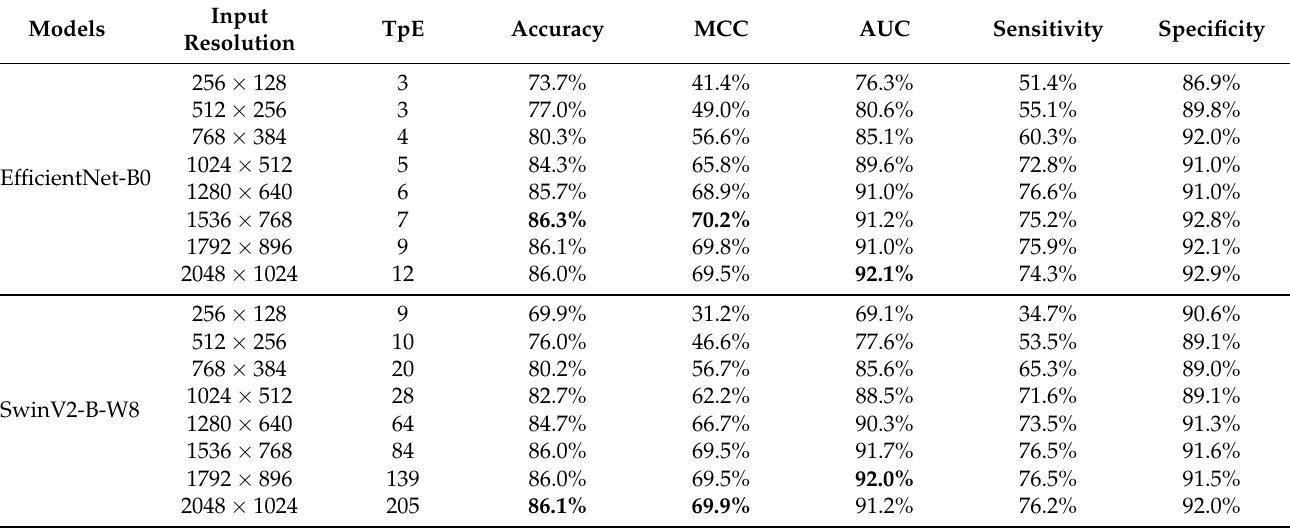
Figure 4. Performance per-lesion for each combination of metrics (Sensitivity, MCC, AUC) and image selection approach ( MIXED top row, EXCLUSIVE bottom row). On the x-axis results are grouped by network families whereas on the y-axis the metric considered is reported. Each color represents a specific lesion (yellow:mass, blue:calcification, green:focal asymmetry, red:architectural distortion). Table 4. Results of the experiments varying the input resolution. In bold the highest value of Accuracy, MCC and AUC for both networks tested. Column TpE indicates the training time per epoch in minutes.